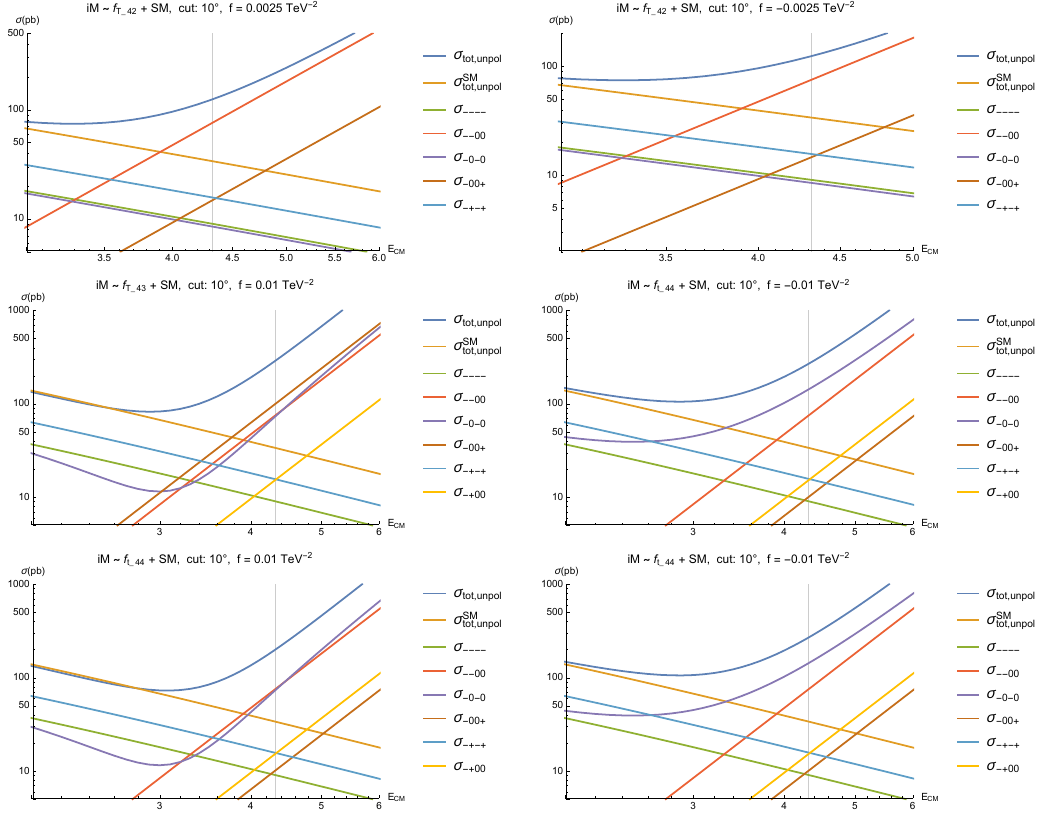
Figure 8 . The polarised contributions to the total unpolarised cross sections (multiplicity taken into account) as functions of the c.o.m. collision energy ( E of f . The left column corresponds to f i shown) polarised cross sections are negligibly small. The total cross sections and the SM total cross sections are also